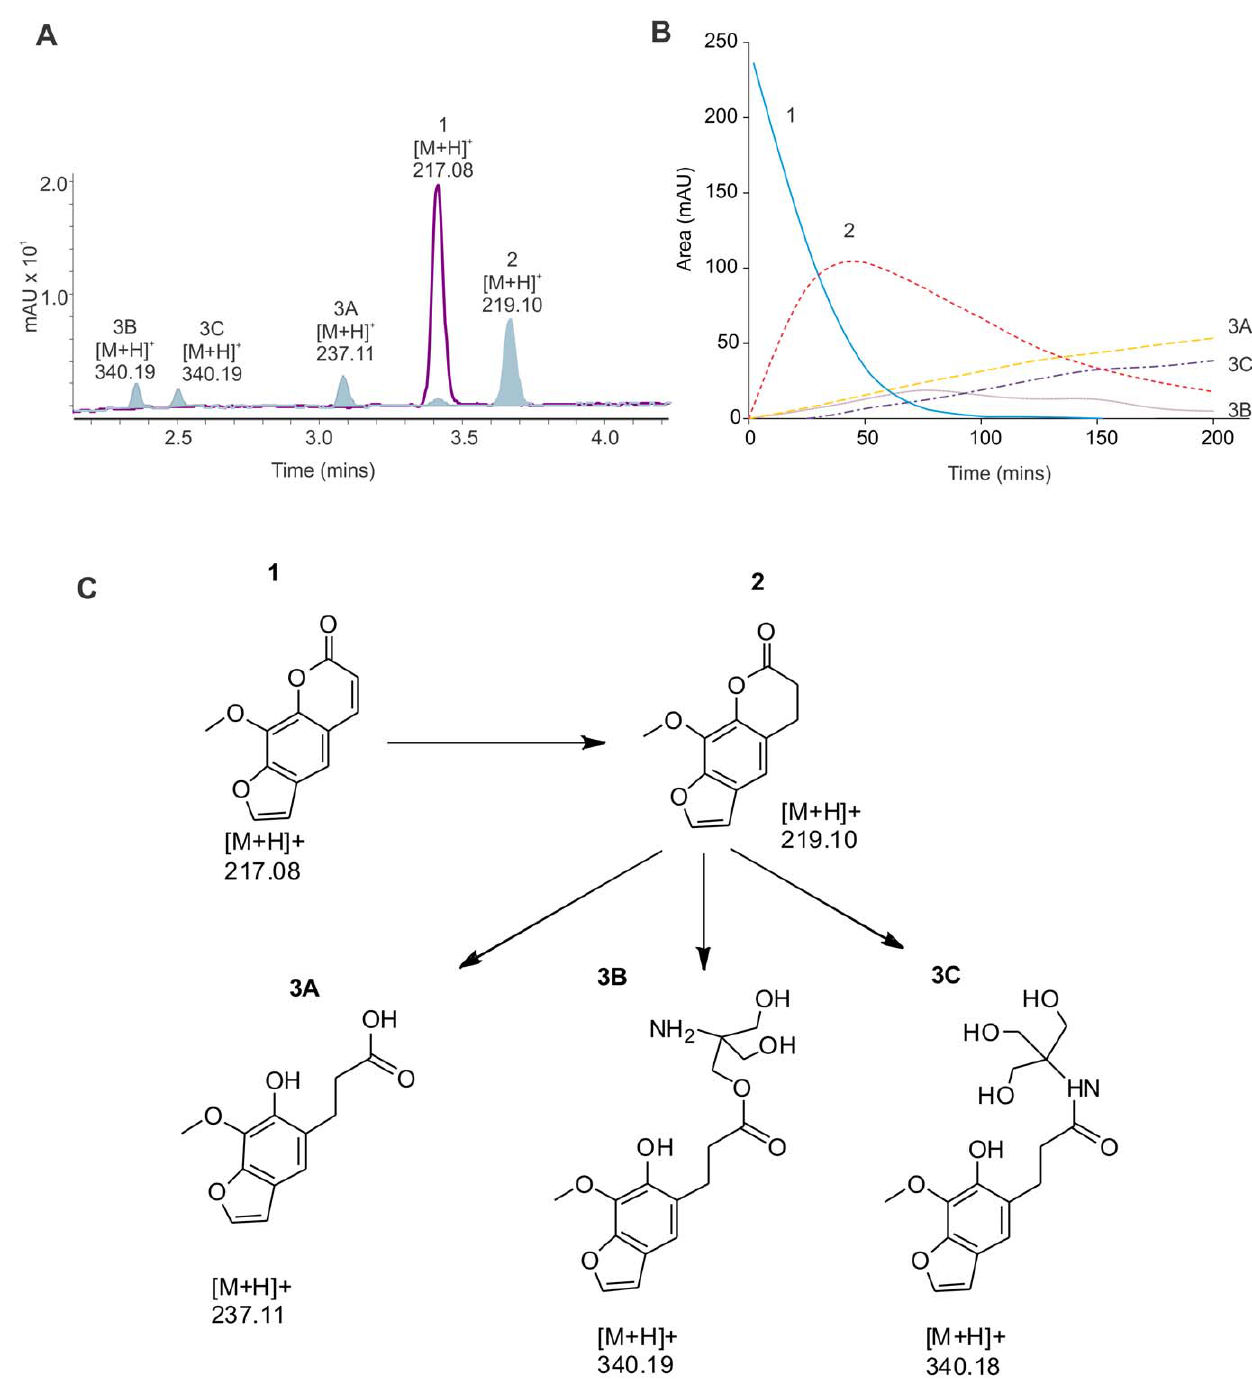
Figure 4. Reduction and spontaneous hydrolysis of 8-MOP. 8-MOP was reduced with MSMEG_2027 and analysed by LCMS. Spectra from both diode array (A) and MS ToF were recorded, diode array peaks are labeled with [M + H] + . The reaction was monitored every 20 minutes and the area of each reaction product was quantified. Predicted reaction products for 8-MOP and its spontaneous hydrolysis products are shown (C). doi:10.1371/journal.pone.0030114.g004 cycle [35]. In the case of coumarin, dihydrocoumarin resulting succinate would enter the citric acid cycle. The other furanocou- marin compounds are similarly reduced by the FDRs and after from the FDR-catalyzed reduction reaction would be spontane- ously hydrolyzed to 3-hydroxyphenyl propionic acid, which could further hydrolysis should be ring cleaved by extradiol dioxygenases be further hydrolyzed to 2,3-dihydroxyphenyl propionic acid by and lysed to produce succinate, thus also providing a carbon melilotate hydroxylase [36], enabling ring meta-cleavage by source. Other metabolic fates might also be possible for the possible hydrolyzed intermediates, such as through condensation extradiol dioxygenases [37,38]. After cleavage, the resulting